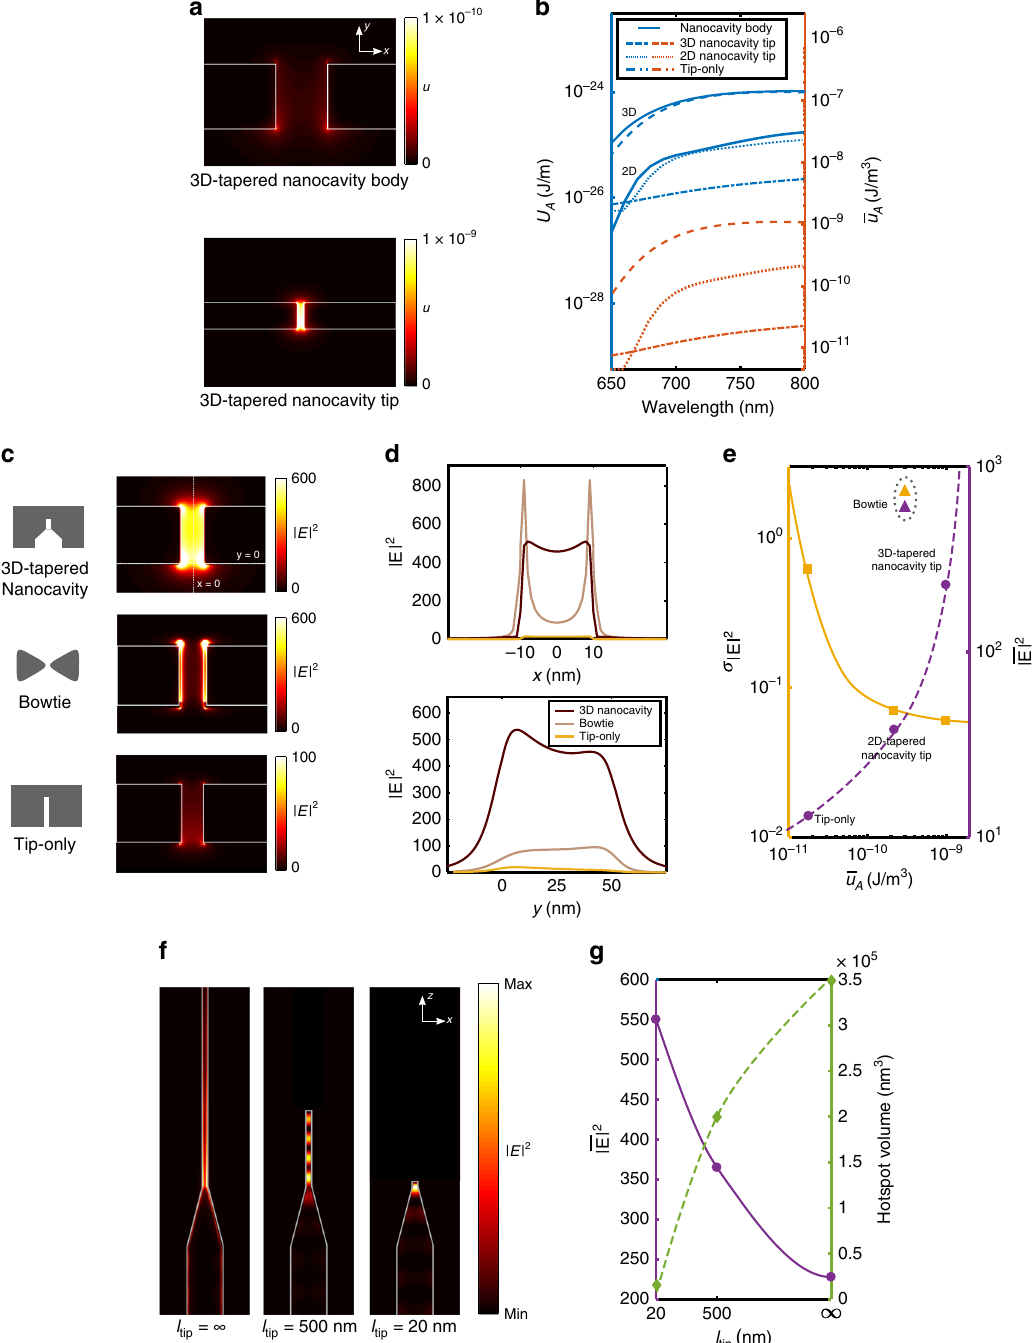
Fig. 2 Design optimization of the 3D-tapered nanocavity using FDTD simulation. a Comparison between the cross-sectional views of the EM energy density pro fi les in the body (top) just before the 3D-taper ( α = 20°) and at the tip (bottom). b The total transversal EM energy U A and average transversal EM energy density u A of the body and tip of the 3D- and 2D-tapered nanocavities and a tip-only stru c ture. c Cross-sectional view of the | E | 2 pro fi les of the 3D-tapered nanocavity (top), a bow tie (middle), and a tip-only structure (bottom) of the same gap size (20 nm × 50 nm). d | E | 2 inside the gaps of the structures at y = 0 (top) and x = 0 (bottom). e Hotspot uniformity σ | E |2 and average | E | 2 at cross-sectional areas of the 3D- and 2D-tapered nanocavities, a tip-only structure (circle), and a bowtie (triangle). f Top view of the | E |² pro fi les in the devices with l tip = 20 nm, 500 nm, and ∞ . g | E |² and hotspot volume at the tips of the devices with varied l tip and differentiating them from the background through enhanced involves illumination of the back-end of the 3D-tapered fl uorescence signal. nanocavity, whereas full illumination mode allows the complete After molecular binding, chips were washed to remove device to be placed under illumination (Supplementary Note 4). unbound molecules and interrogated using tail-end and full Excitation light from a near-infrared light-emitting diode light illumination modes (Fig. 3a, b). The tail-end illumination mode source (750 nm) was incident on the 3D-tapered nanocavities and